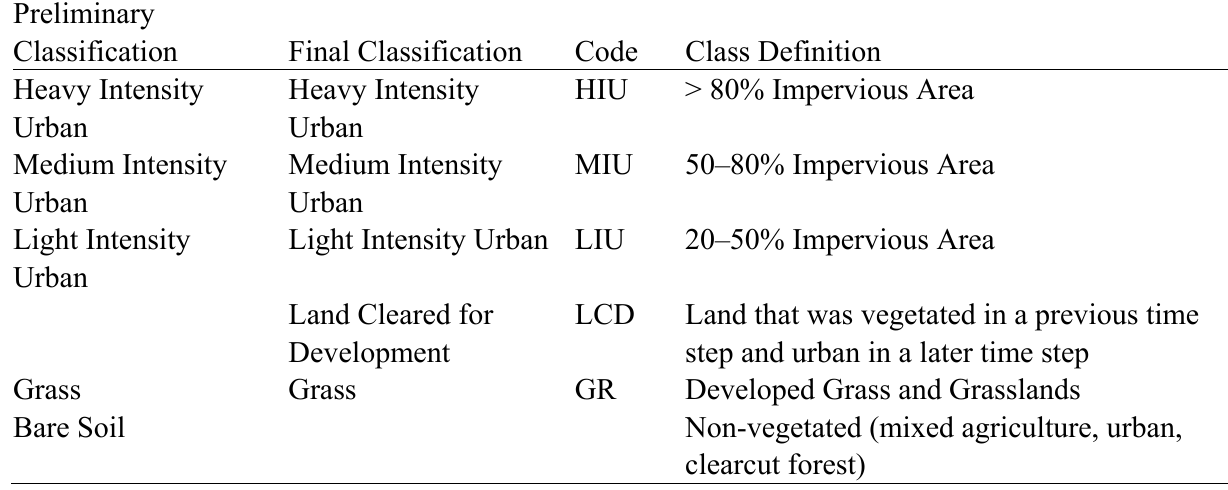
Table 1. Preliminary 9-class and final 14-class land cover classification